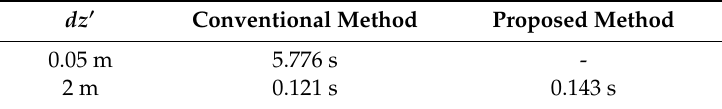
Table 3. Comparison of the computation time between two methods.